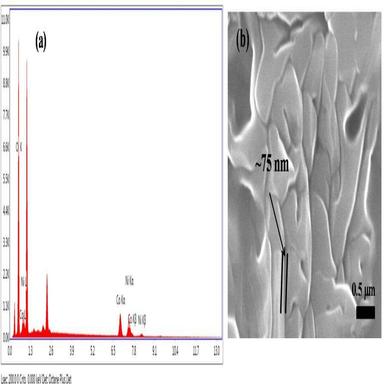
(a) Energy Dispersive Spectroscopy (EDS) Spectra of synthesized A(NC) nanocomposites, (b) SEM images of synthesized A(NC) nanocomposite.